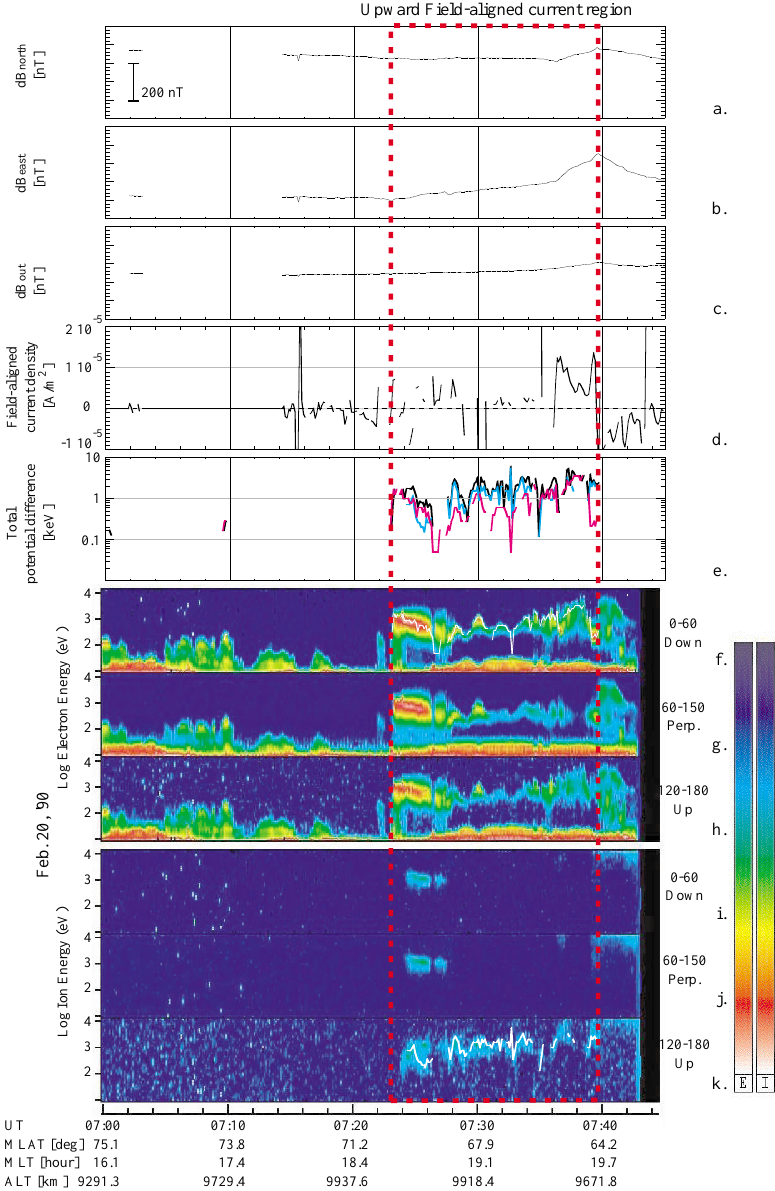
Fig. 3. Summary plot of the event 90022006. (a–c) Magnetic field perturbation for the northward, eastward, and radial direction by MGF. (d) The field-aligned current density estimated by the magnetometer data. The estimated values are mapped down to the ionosphere (120km) with assumption of the dipole magnetic field. (e) Potential differences estimated from the peak energies of the downward electrons and UFIs. Total (black), above (red), and below (blue) the satellite. (f–h) E-t (Energy-time) spectrogram of electron data by LEP. (i–k) E-t (Energy- time) spectrogram of ion data by LEP. Detected peak energies of the downward electrons and the UFIs are also indicated over the panel (f) (downward electron) and panel (k) (upward